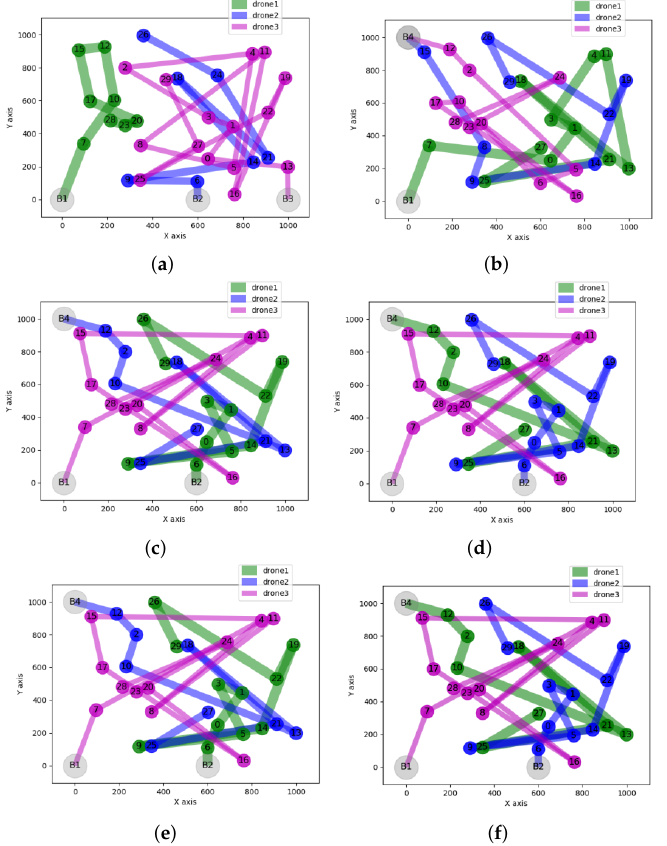
Figure 18. ( a ) First visitation; ( b ) second visitation; ( c ) third visitation; ( d ) fourth visitation; ( e ) fifth visitation; ( f ) sixth